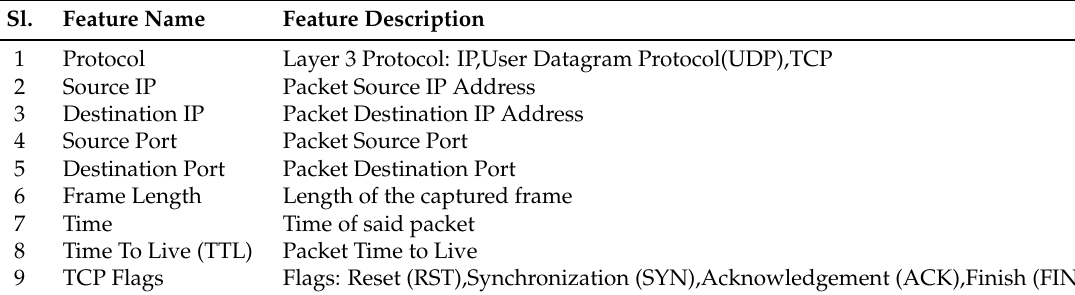
Figure 3. Overview of the proposed approach Table 1. Data–points collected.